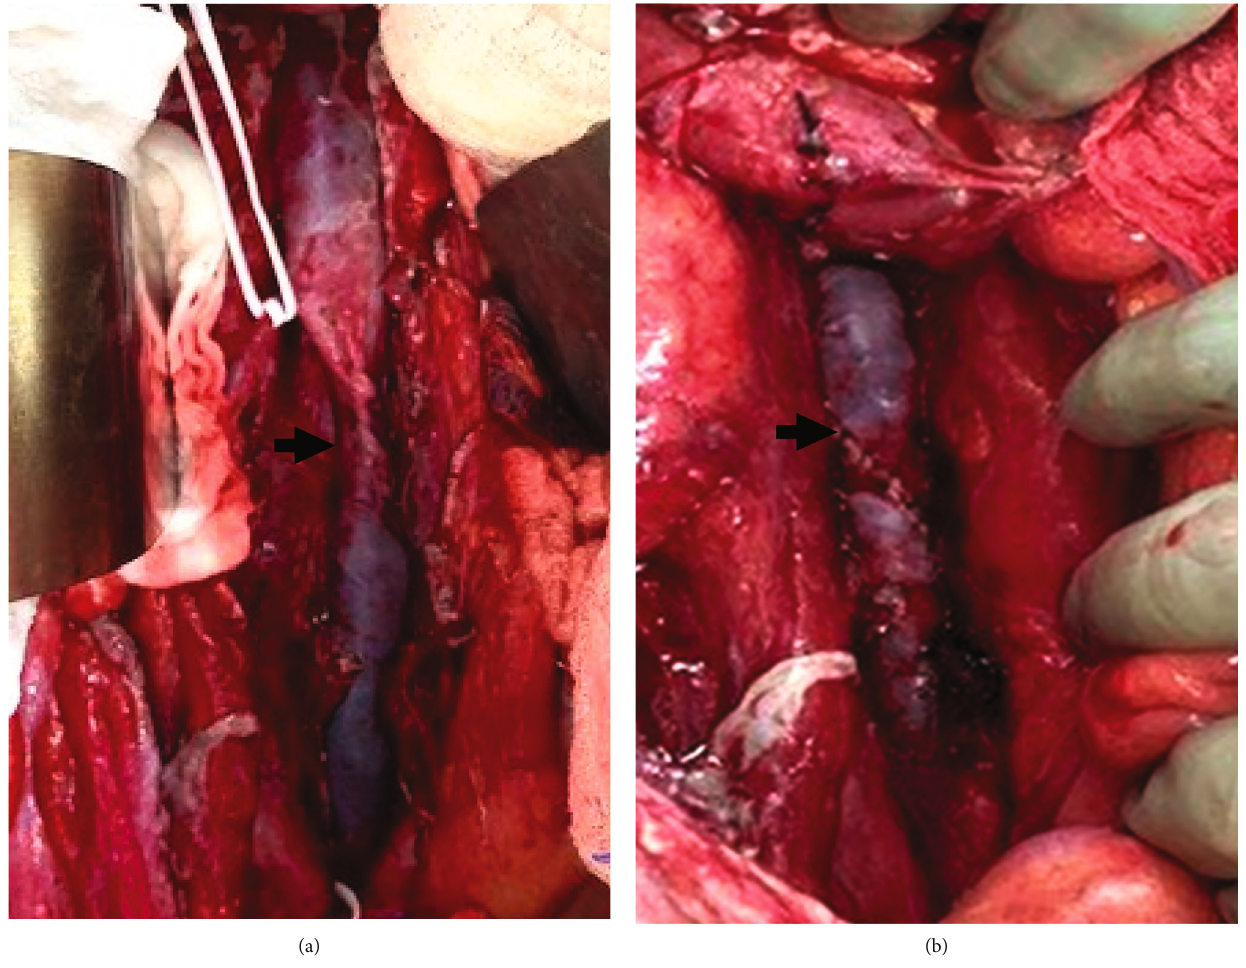
Figure 2: Intraoperative image of IVC: (a) luminal narrowing status post lateral venorrhaphy prior to patch repair and (b) restored luminal diameter following patch